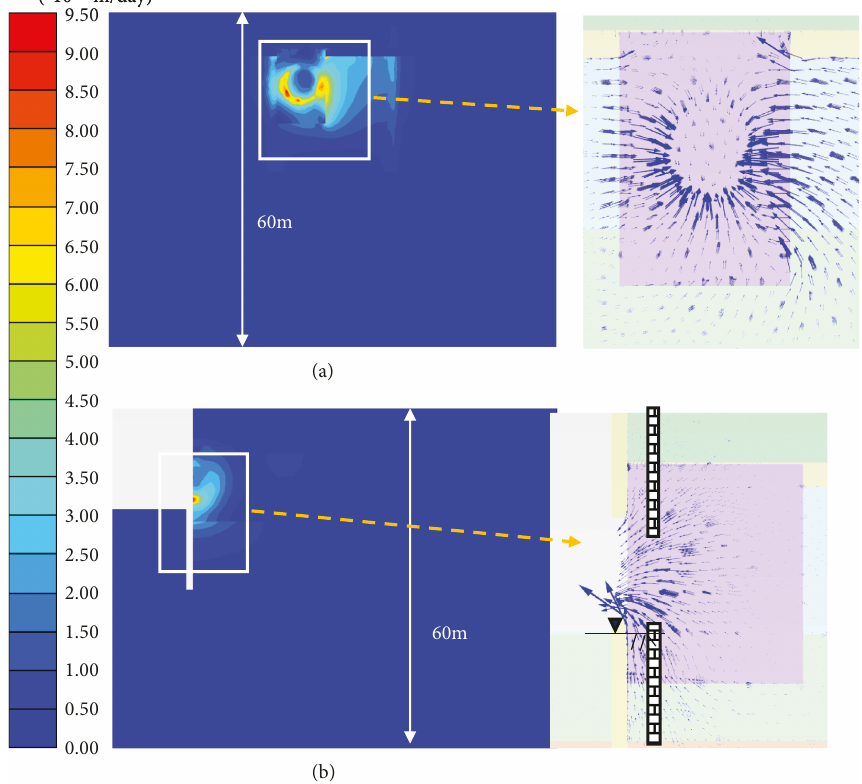
Figure 12: Flow line at failure caused by launching of a shield. (a) Transverse direction. (b) Longitudinal